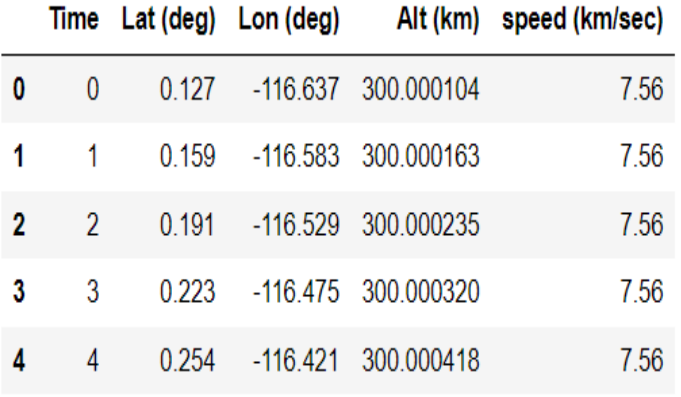
Figure 4. LEO-Satellite Features: latitude, longitude, and altitude (LLA) data from the NTN Simulator.